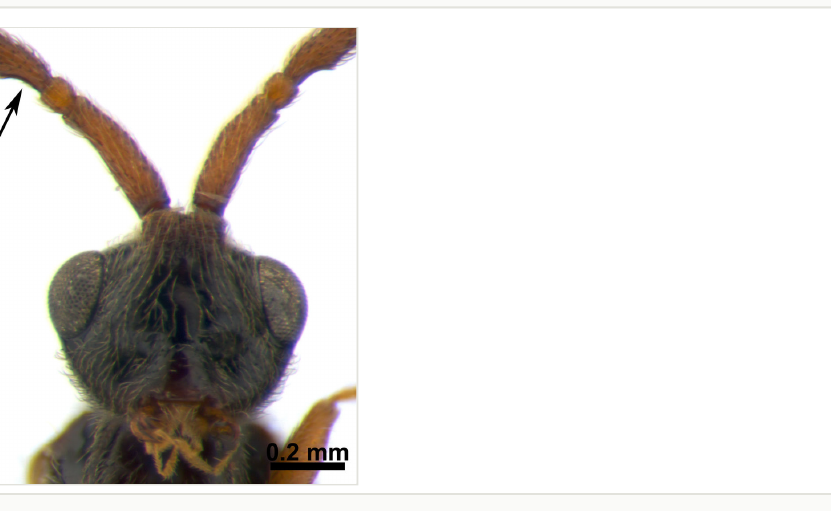
Figure 3. Acanospilus heterocerus Haliday, male. Head in frontal